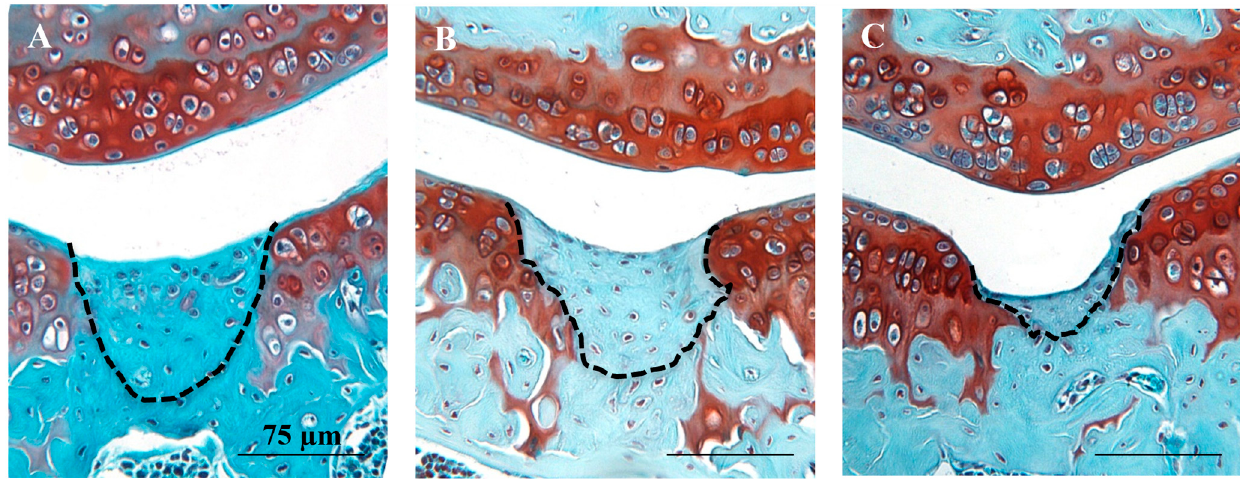
Figure A1. Cartilage formation and repair after joint surface injury. Safranin O and fast green stained sections from individual mouse knees showing the injury site in the patellar groove at 8 weeks post-injury in the sample groups ( A ) human UC-MSCs, ( B ) human BM-MSCs and ( C ) the control group (no cells injected). Clear repair tissue (indicated by dashed lines) can be seen in the MSC treated sections, whereas only minimal repair is present in the control group. Scale bars = 75 µm.